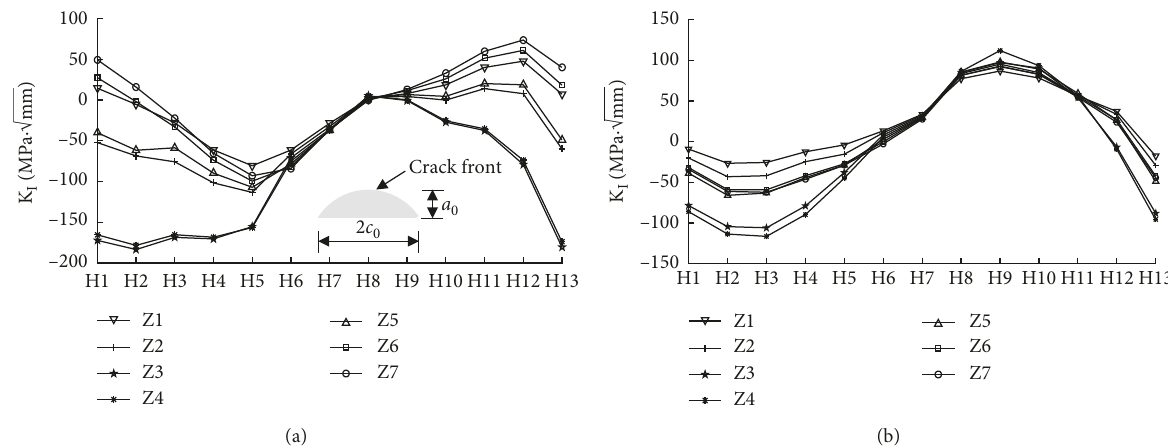
Figure 11: Influence line of K I of the crack at the welding toes of the U-rib and top deck. (a) Crack at the welding toe of the top deck. (b) Crack at the welding toe of the U-rib web.